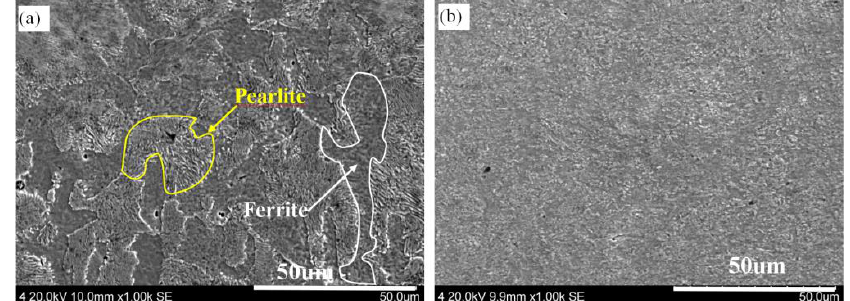
Figure 7. Unaffected microstructure of wrought substrate: ( a ) 1045 steel; ( b ) P20 steel. Figure 7. Una ff ected microstructure of wrought substrate: ( a ) 1045 steel; ( b ) P20